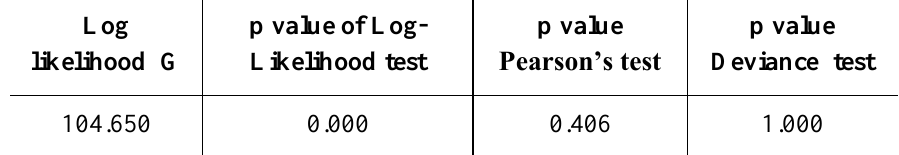
Table 05: Summary Statistics of Ordinal Logistic Model Log p value of likelihood G